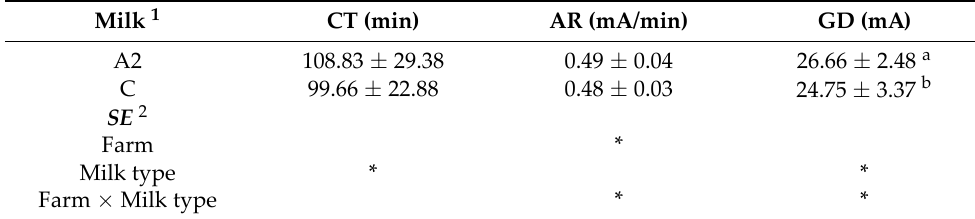
Table 4. Acid coagulation properties calculated with Optigraph ® of A2 and control